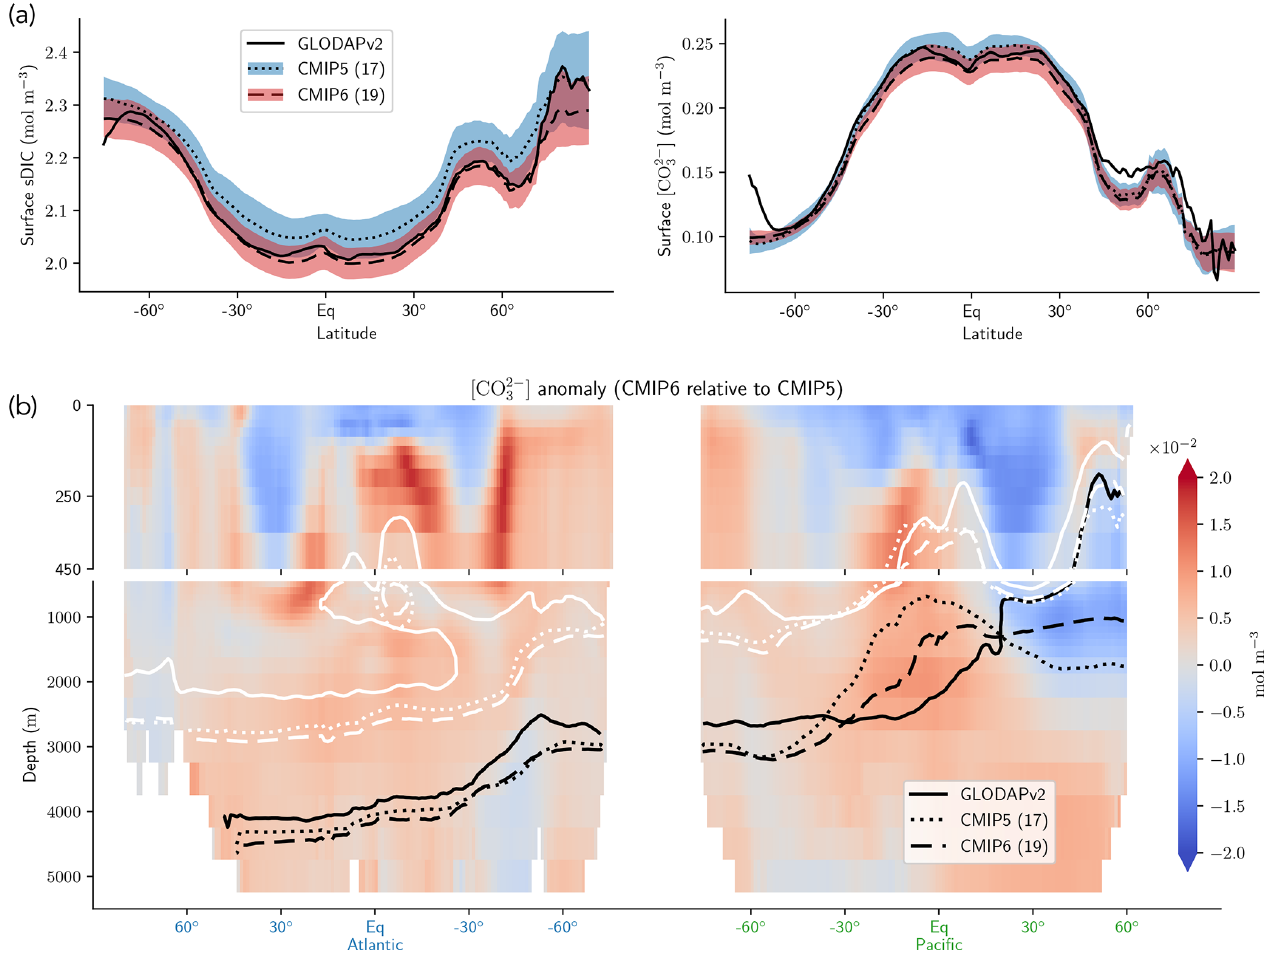
Figure D6. Complementary carbonate system assessment. (a) Open-ocean zonal averages of the surface sDIC (left) and carbonate ion concentration (right). (b) Atlantic–Pacific zonal average of the difference between the CMIP6 and CMIP5 ensemble means of the carbonate ion concentration. The saturation horizon depth for calcite (black lines) and aragonite (white lines) is shown for GLODAPv2 and CMIP5 and CMIP6 ensemble